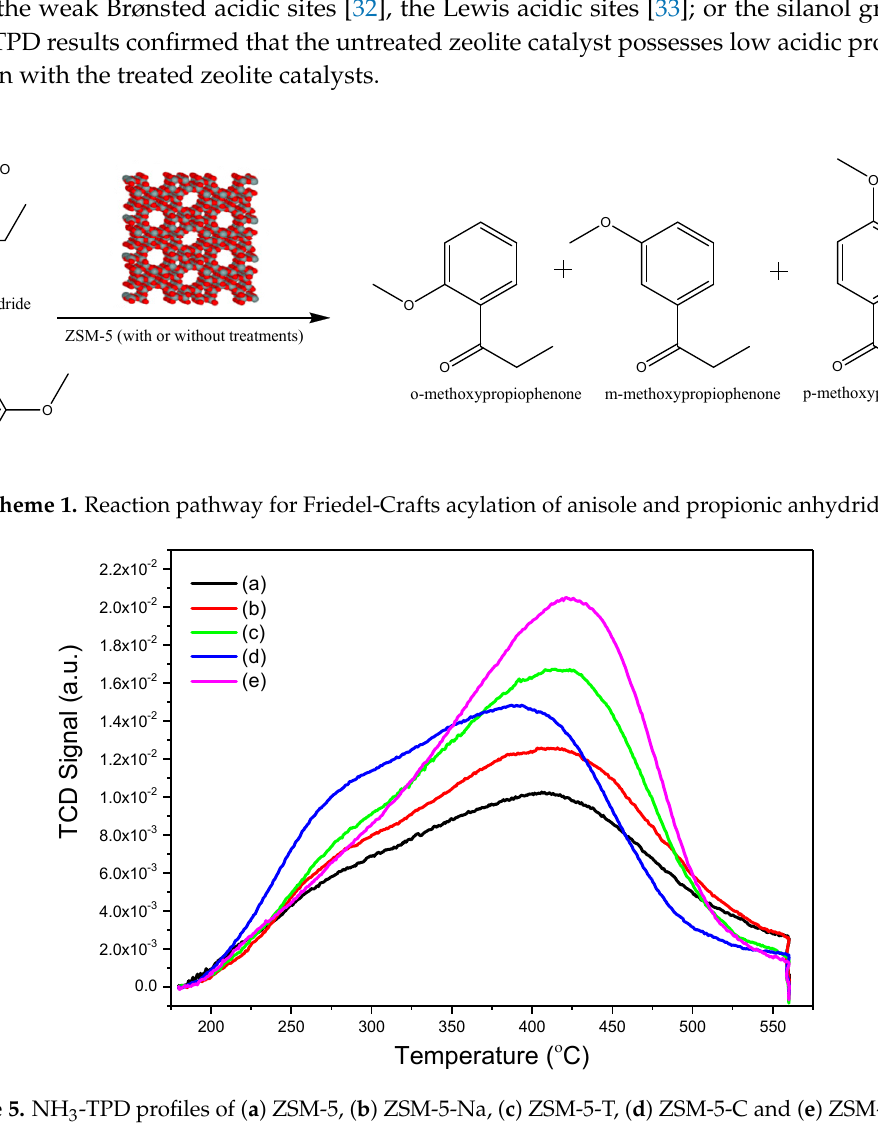
Figure 5. NH 3 ‐ TPD profiles of ( a ) ZSM ‐ 5, ( b ) ZSM ‐ 5 ‐ Na, ( c ) ZSM ‐ 5 ‐ T, ( d ) ZSM ‐ 5 ‐ C and ( e ) ZSM ‐ 5 ‐ CT. Table 4. Determination of total acidity of untreated and treated zeolites using NH 3 ‐ TPD analysis.